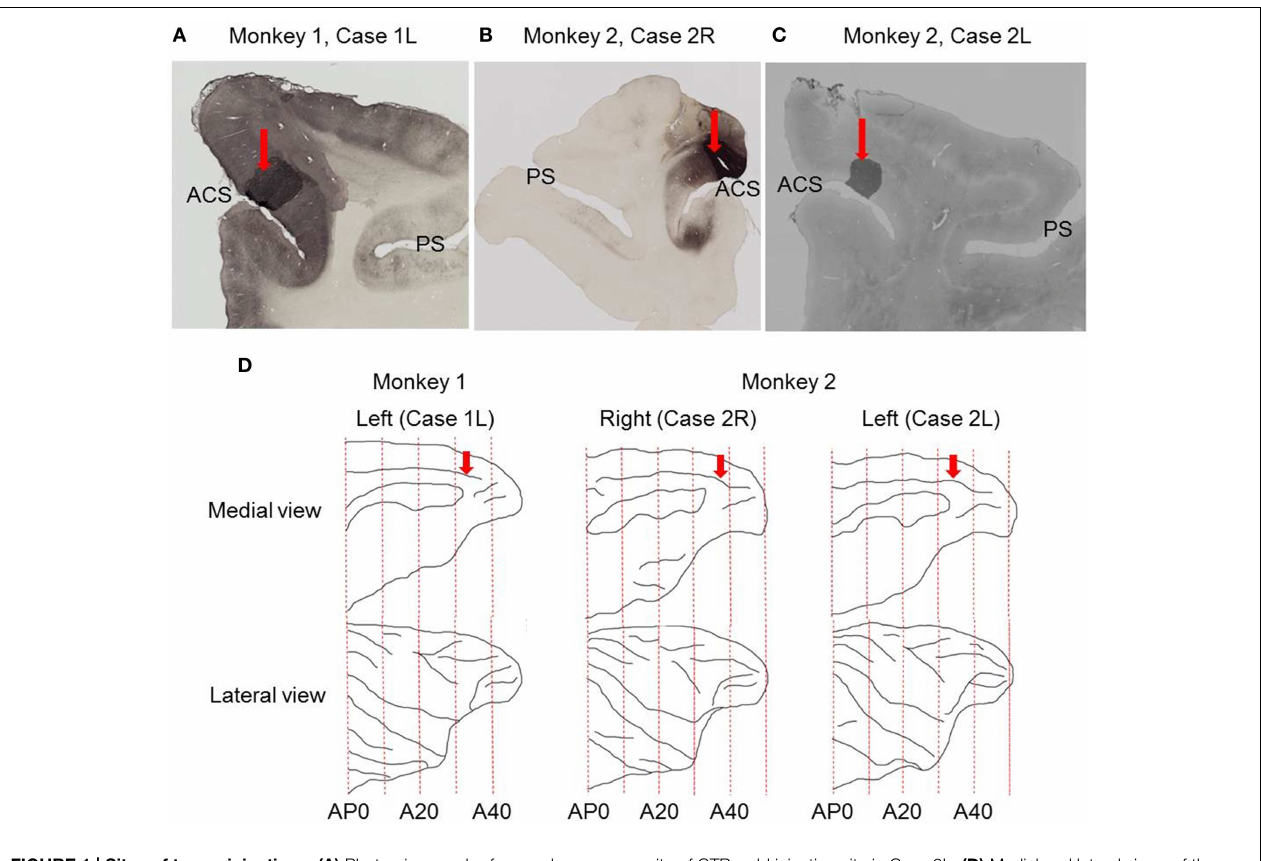
site of CTB-gold injection site in Case 2L. (D) Medial and lateral views of the brain reconstructed from structural MRI images. Red arrows indicate the sites of tracer injections into the dorsal bank of the anterior cingulate sulcus. ACS, anterior cingulate sulcus; PS, principal